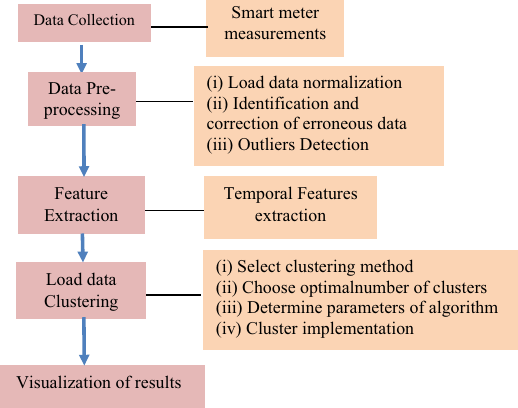
Fig. 1 Process model of consumer